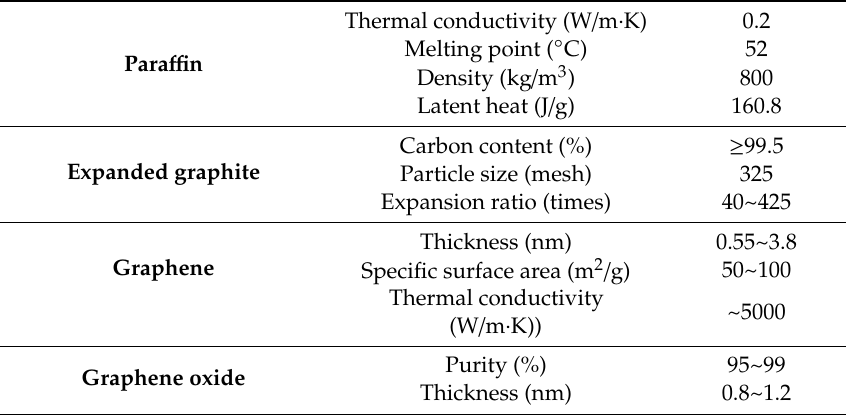
Table 1. The properties of